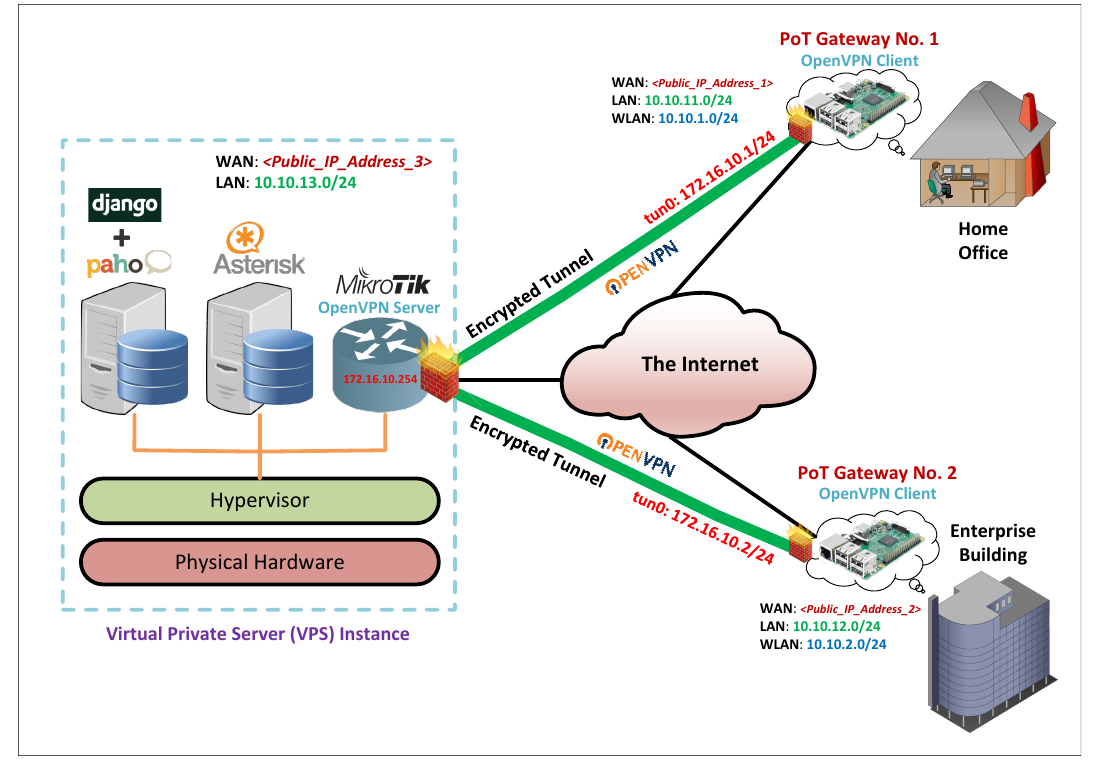
Figure 2. Overview of LTC OpenVPN implementation to establish secure tunnels for traffic exchange.